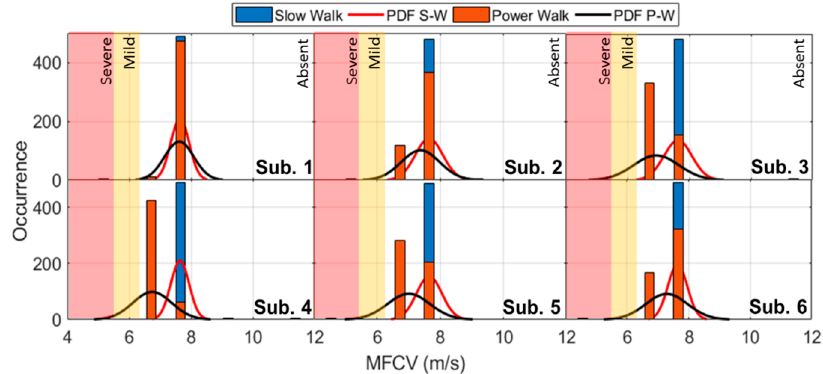
Figure 6. Subject-by-subject MFCV values occurrence and probability density functions in 10-m slow walk protocol (blue histogram) and considering a power walk (red histogram).